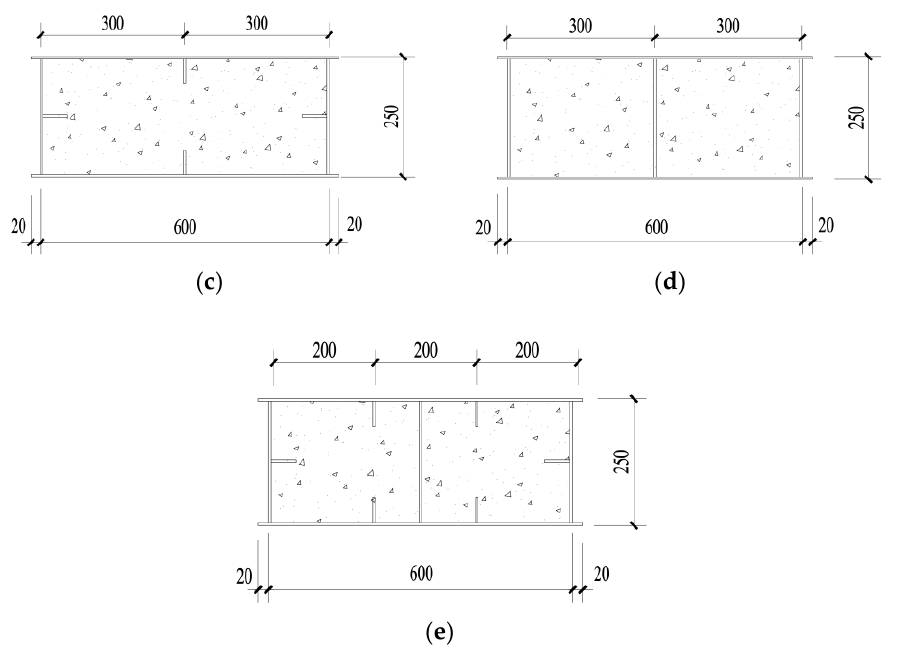
Figure 2. Cross-section of concrete-filled steel box slabs: ( a ) S-1; ( b ) S-2/6/7; ( c ) S-3; ( d ) S-4; ( e ) S-5.